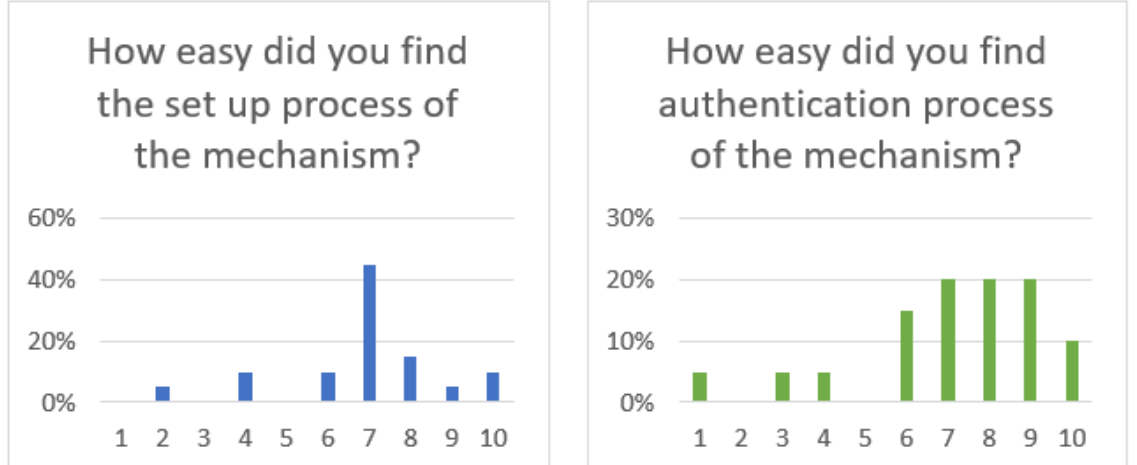
Figure 11. User experience results (1 being very hard, and 10 very easy).